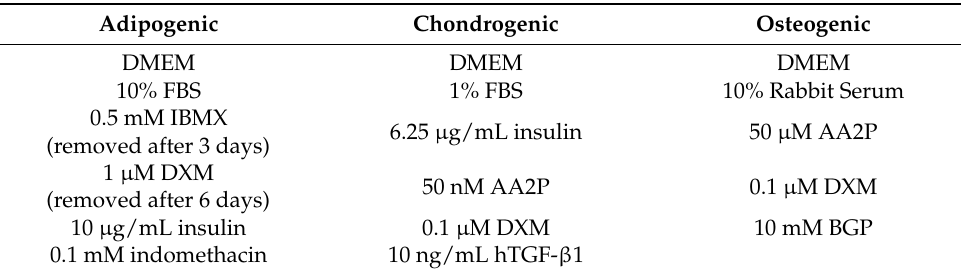
Table 1. Composition of induction media